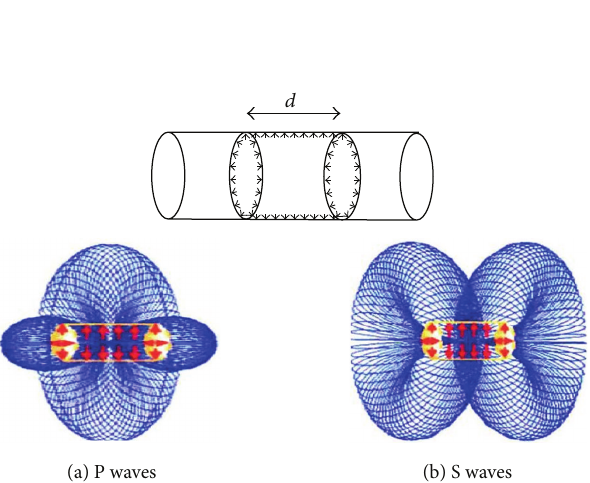
Figure 8: Diagrams of propagation of waves created by uniform pressure.